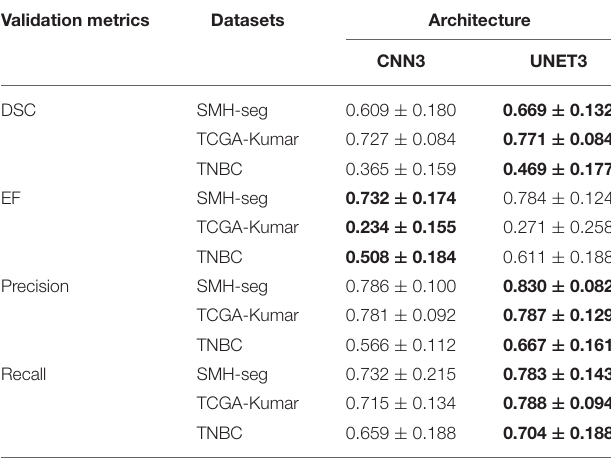
TABLE 3 | Mean validation metrics accross segmentation models and datasets. Validation